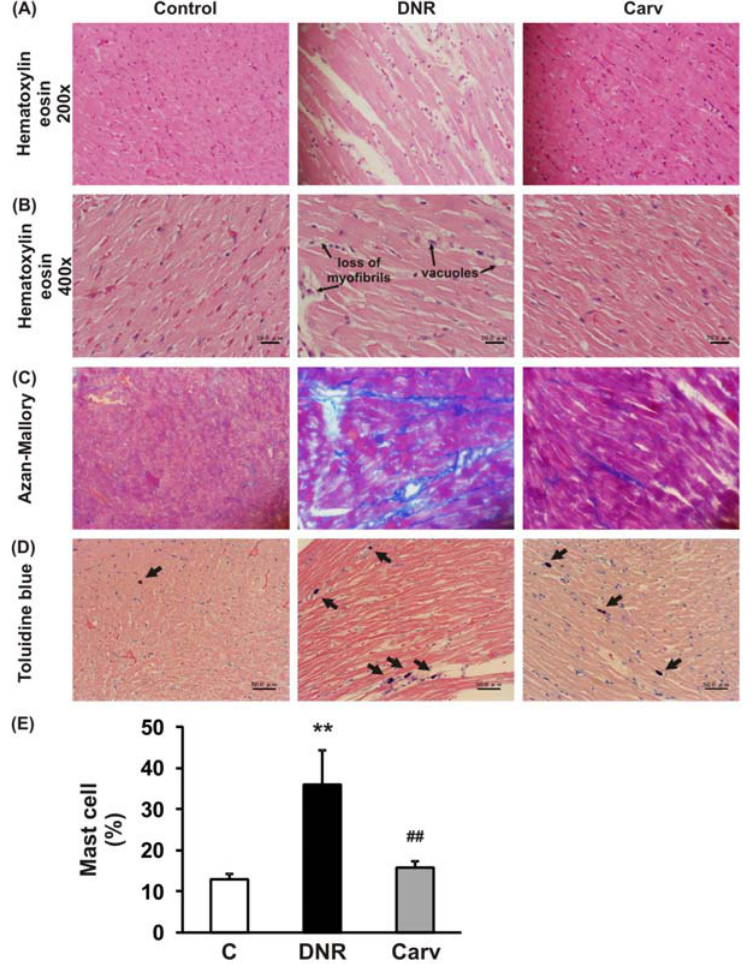
Figure 2. A,B , Hematoxylin and eosin staining of the cross-sectional tissue slices of hearts depicting vacuolation and degeneration of cardiac fibers at the magnification of 200x and 400x, respectively. C , Azan-Mallory staining for fibrosis of the cross-sectional tissue slices of hearts. Fibrosis is indicated by the blue area as opposed to the red myocardium at the magnification of 200x. D , Toluidine blue staining for mast cell of the cross-sectional tissue slices of hearts. Metachromatic staining of mast cell granules was handy to identify these cells. Toluidine blue-positive mast cell was demonstrated in purple (shown by arrows) at the magnification of 200x. E , Quantification of mast cell staining. In E, the white, black and grey bars, respectively, represent the control (age-matched normal rats), DNR (DNR- treated rats administered with vehicle) and the Carv (DNR-treated rats administered with carvedilol (30 mg/kg/day)) group. Each bar represents mean ± S.E.M. ** p < 0.01 vs. group Control; ## p < 0.01 vs. group